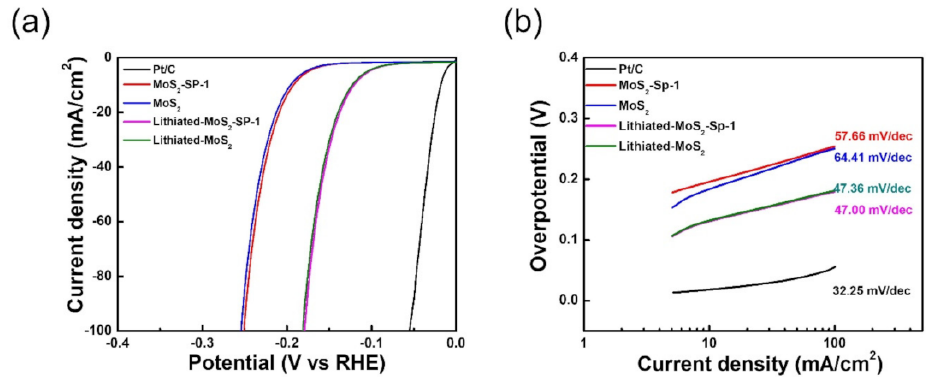
Figure 5. ( a , b ) Polarization curves and Tafelplots of 1T-MoS 2 /SP-1 and 1T-MoS 2 before and after lithiation,